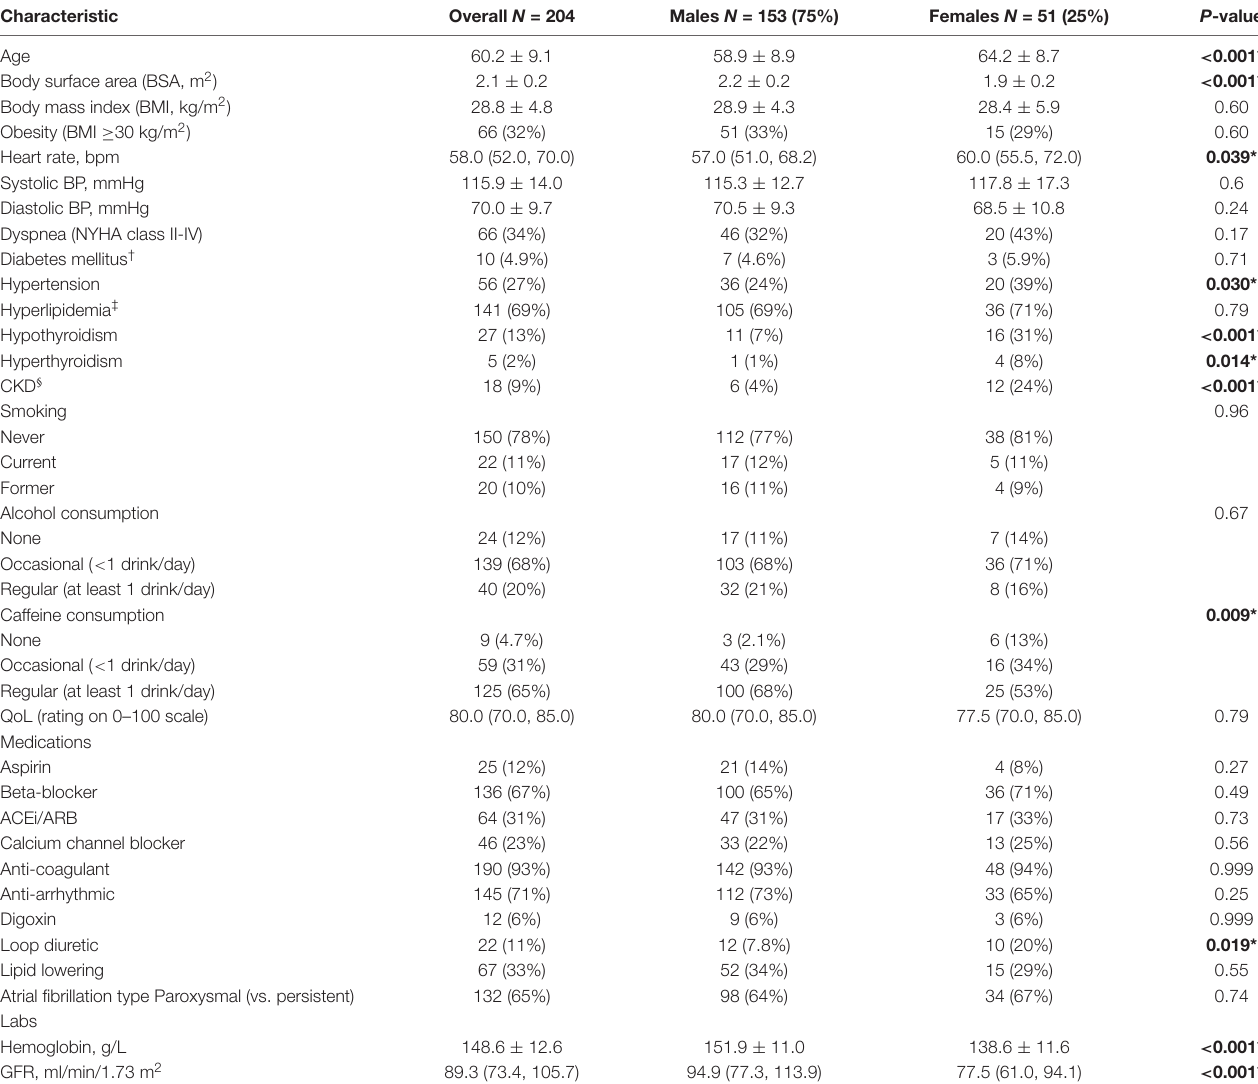
TABLE 1 | Baseline non-imaging characteristics of the total study cohort, stratified by sex.